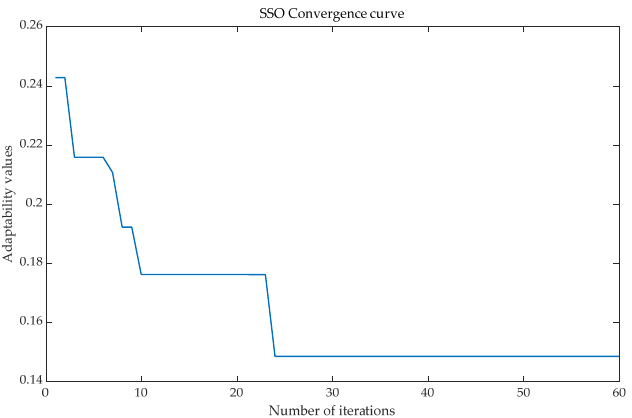
Figure 8. Wind power prediction results of different methods.